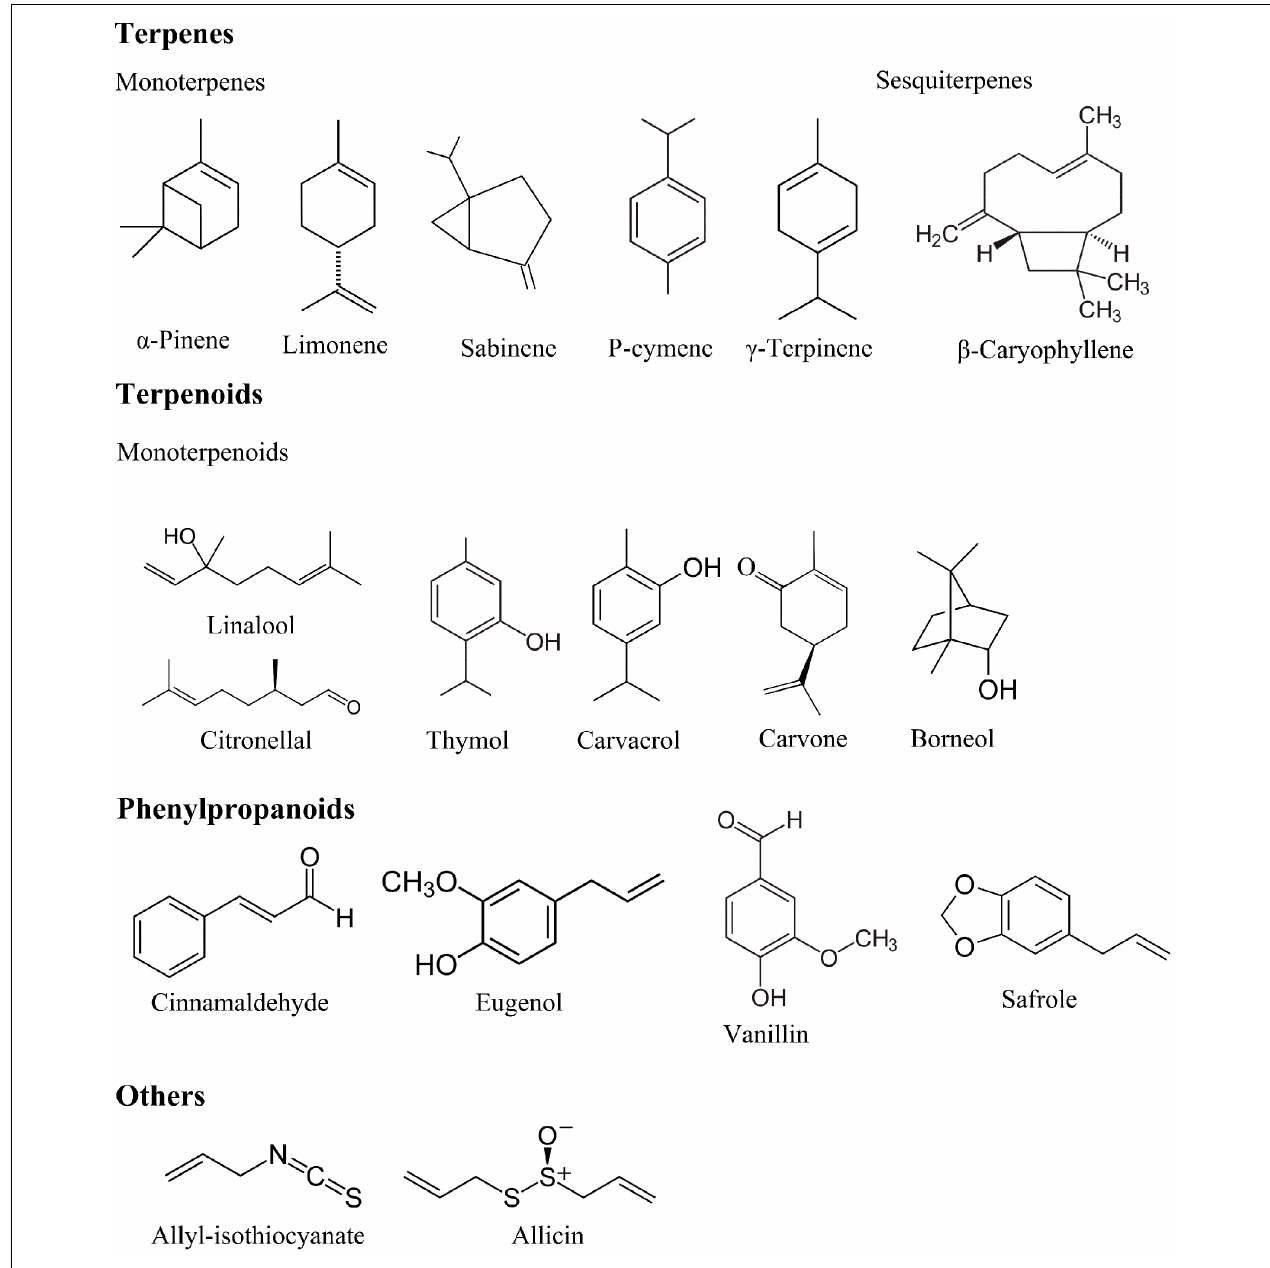
FIGURE 1 | Chemical structures of selected essential oil